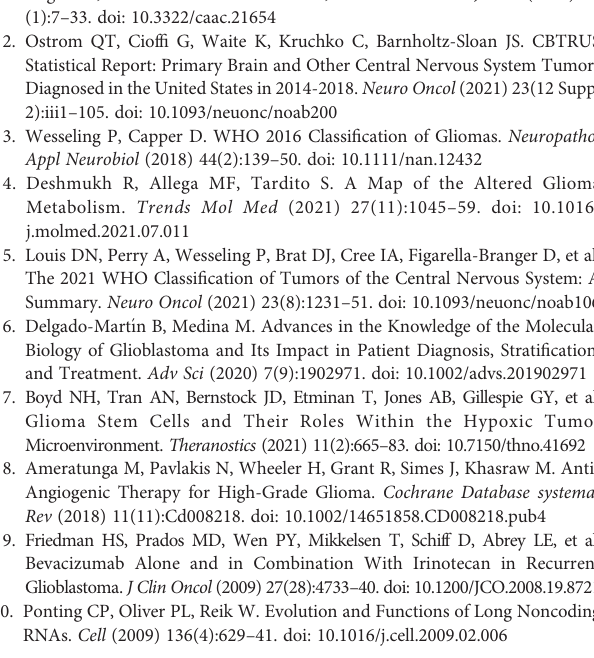
Top: The risk score curve of the survival status of the patients. Middle: Survival status of the patients. Higher mortality corresponds to a higher risk score. Bottom: Heatmapoftheexpressionpro fi lesofthe fi veprognosticgenesinthelow-andhigh- risk group. (B) Calibration curve for the overall survival nomogram model. The dashed diagonal line represents the ideal nomogram, and the blue line, red line and orange line represent the 1-year observed nomograms. (C) Correlation analysis of VEGFA gene expression and MSI. The horizontal axis represents the expression distribution of the gene, and the ordinate is the expression distribution of the MSI score. The density curve on the right represents the distribution trend of the MSI score, and the upper density curve represents the distribution trend of the VEGFA gene. Supplementary Figure 3 | Positive correlation between VEGFA gene expression and immune cell scores. (A – F) Spearman correlation analysis of VEGFA gene expression and B cell expression, CD4+ T cell expression, CD8+ T cell expression, neutrophil expression, macrophage expression, and myeloid dendritic cell expression, respectively, using TCGA data (663 glioma tumors). A positive correlation between VEGFA gene expression and CD8+ T cell expression or neutrophil expression was found. Supplementary Figure 4 | lncRNA-RP11-732M18.3 promotes the expression of NRP1. (A, B) The expression of NRP1 was detected using WB in ECs after 48h of co-culture with lncRNA-RP11-732M18.3 knockdown cells or overexpressing cells. Knockdown of lncRNA-RP11-732M18.3 decreased NRP1, and overexpression increased. All experiments were performed in triplicate (n = 5, *p < 0.05). Supplementary Figure 5 | Biological information analysis of lncRNA-RP11- 732M18.3. (A) The target protein 14-3-3 b / a was speci fi cally co- immunoprecipitated from U87MG cell extracts and the immunoprecipitates were validated using tandem mass spectrometry. The peptides of EP300 were extracted from the cell extracts and analyzed by LC-MS/MS. (B) A spearman correlation analysis of EP300 gene expression and VEGFA gene expression in 120 TCGA samples without radiotherapy. A positive correlation was found between EP300 and